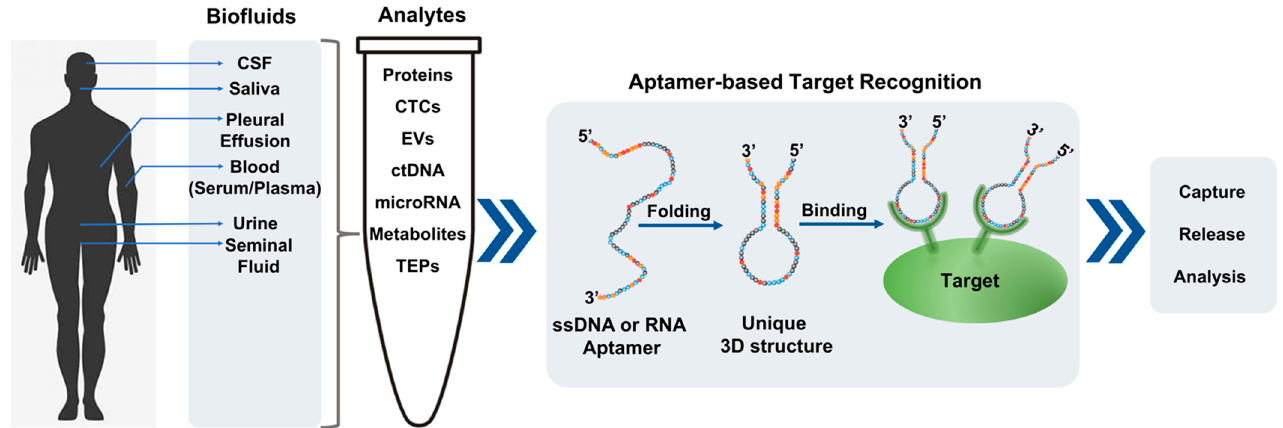
Figure 1. Schematic diagram for common aptamer selection and their applications for circulating tumor targets in liquid biopsy. CSF: Cerebrospinal fluids; CTCs: Circulating tumor cells; ctDNA: Circulating tumor DNA; TEPs: Tumor-educated platelets; EVs: Extracellular vesicles; ssDNA: Single-stranded DNA.